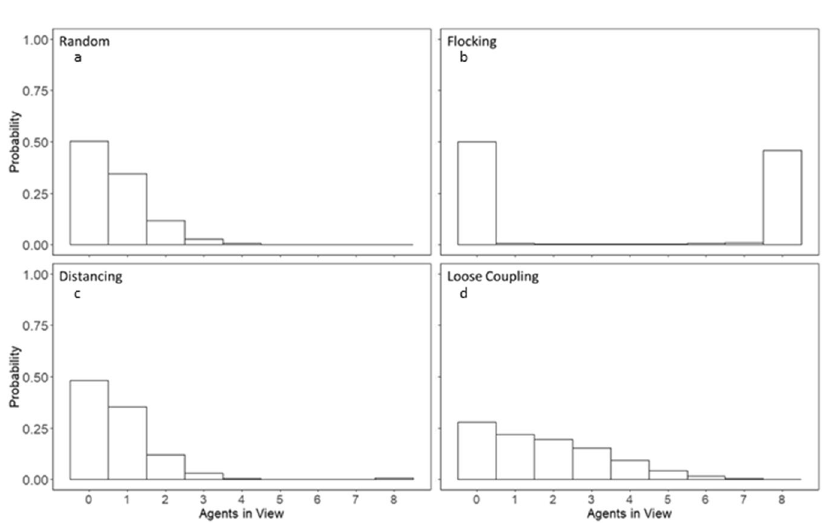
Figure 6. Normalized histogram of the number of agents in view during the search time period respective to only human